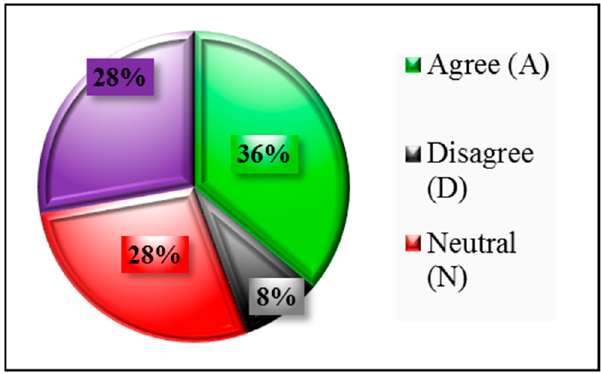
Figure 4. Client presence in the process dimension of the agile process .